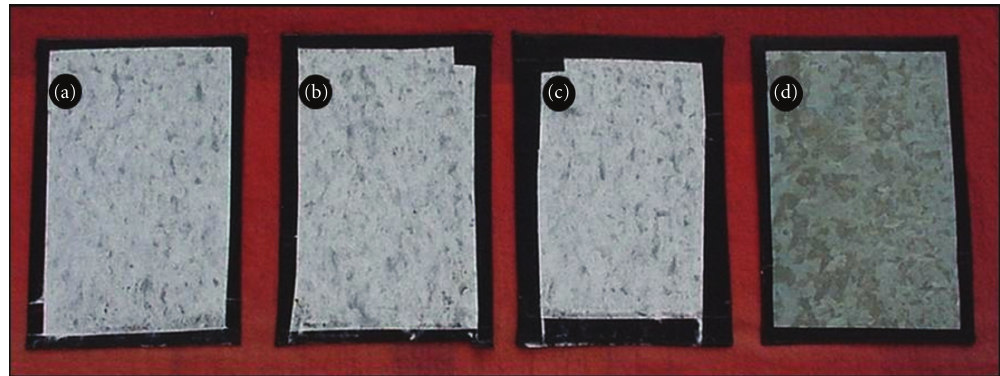
Figure 9: Aspects of the surface conditions of the galvanized steel after 168 h in the saline fog chamber: (a) untreated, (b) inhibitor 5%, (c) phosphated, (d) chromated. The whitish aspect of the first three samples is due to the zinc corrosion products.